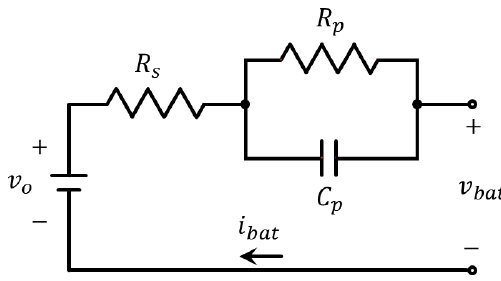
Figure 3. Equivalent circuit model of